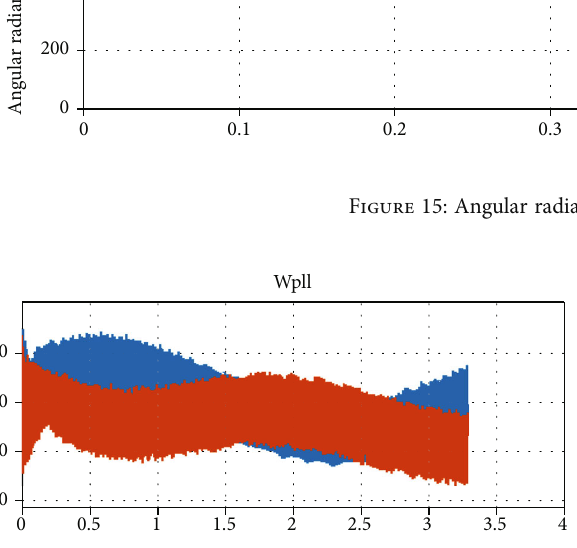
Figure 16: Angular rad/sec during stable